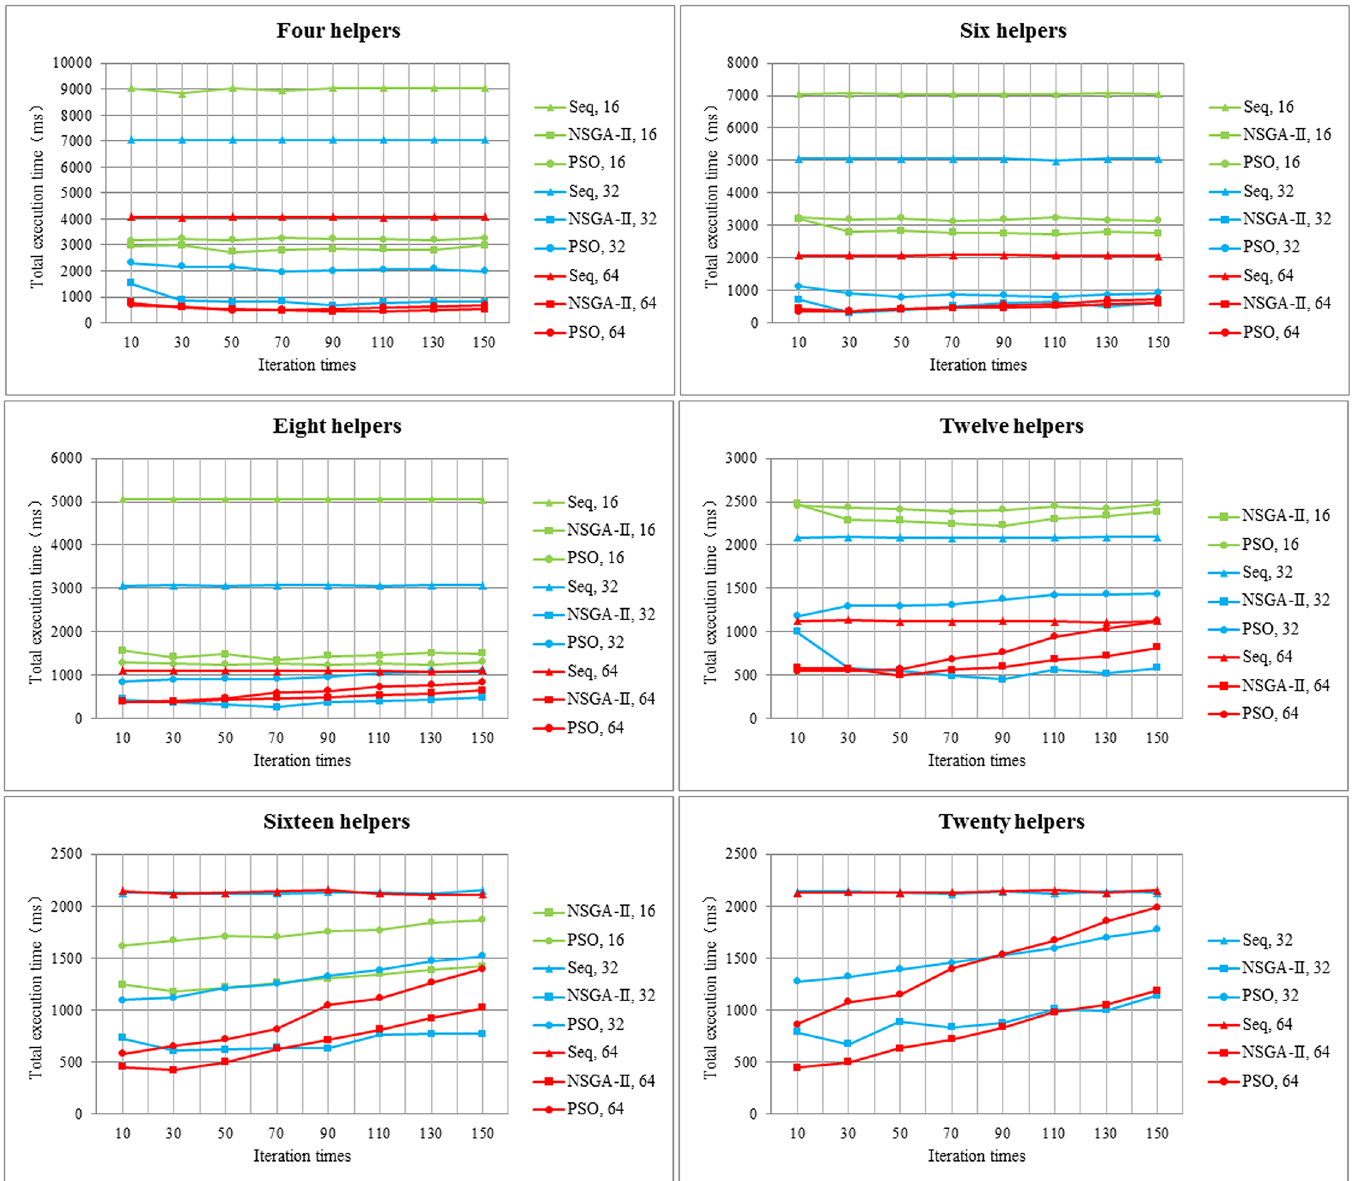
Fig 7. Total execution time with different number of tasks, helpers. The x-axis and y-axis represents iteration times and total execution time, respectively. Every line graph represents a number of helpers. We use triangle, square, and circle to denote sequential scheduling, NSGA-II and PSO, respectively. Green, blue and red show different task numbers